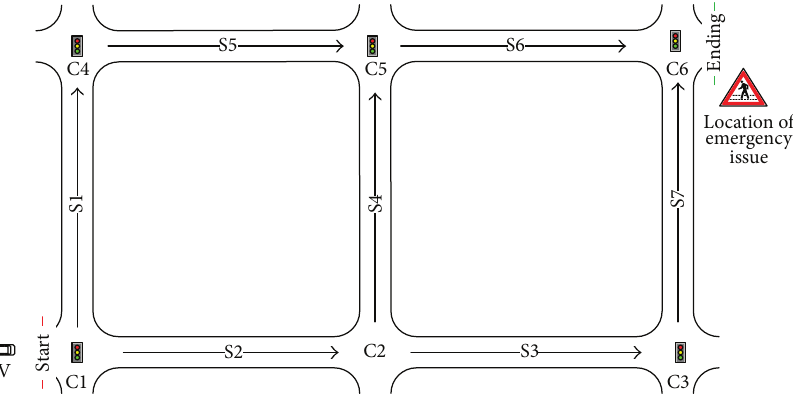
Figure 4: The simulation model of road network in beijing.